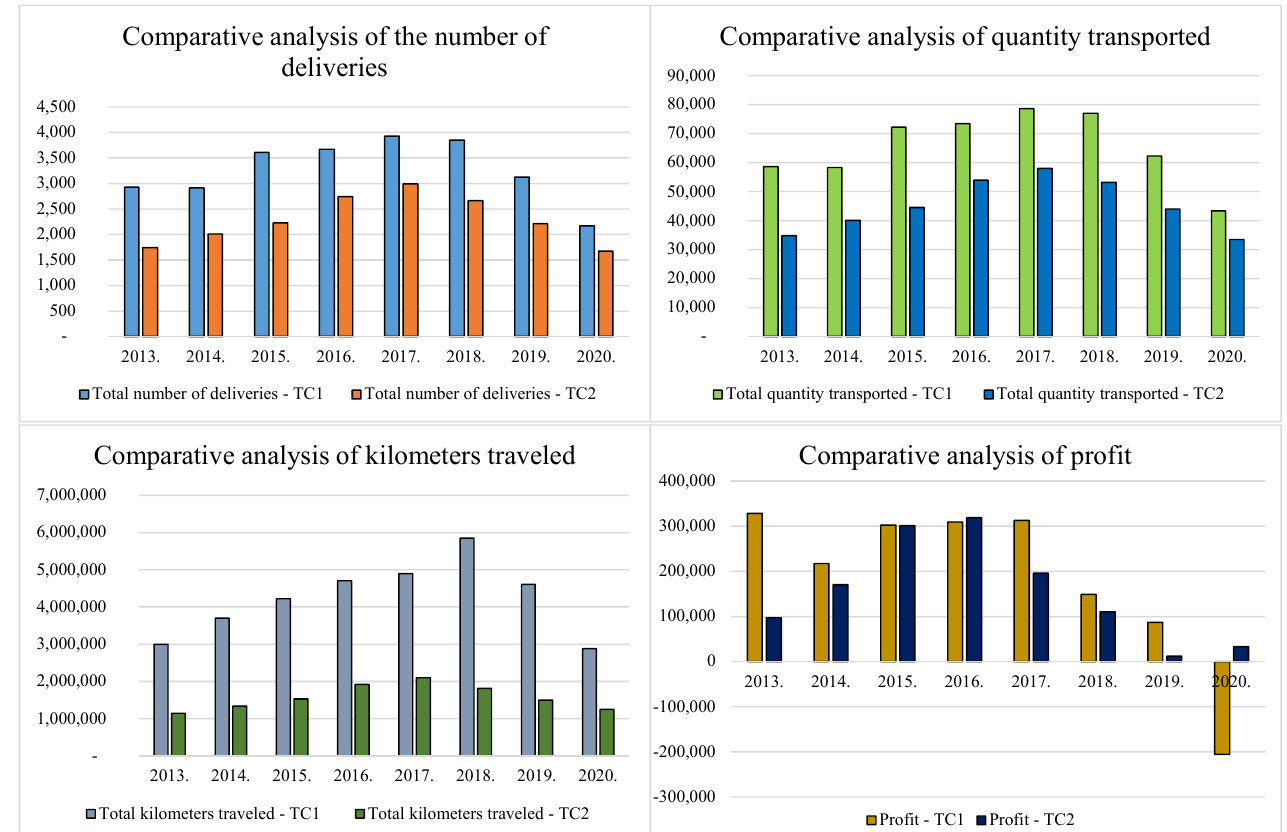
Figure 7. Graphical representation of a comparative analysis of the number of deliveries, quantity transported, kilometers traveled, and profit.